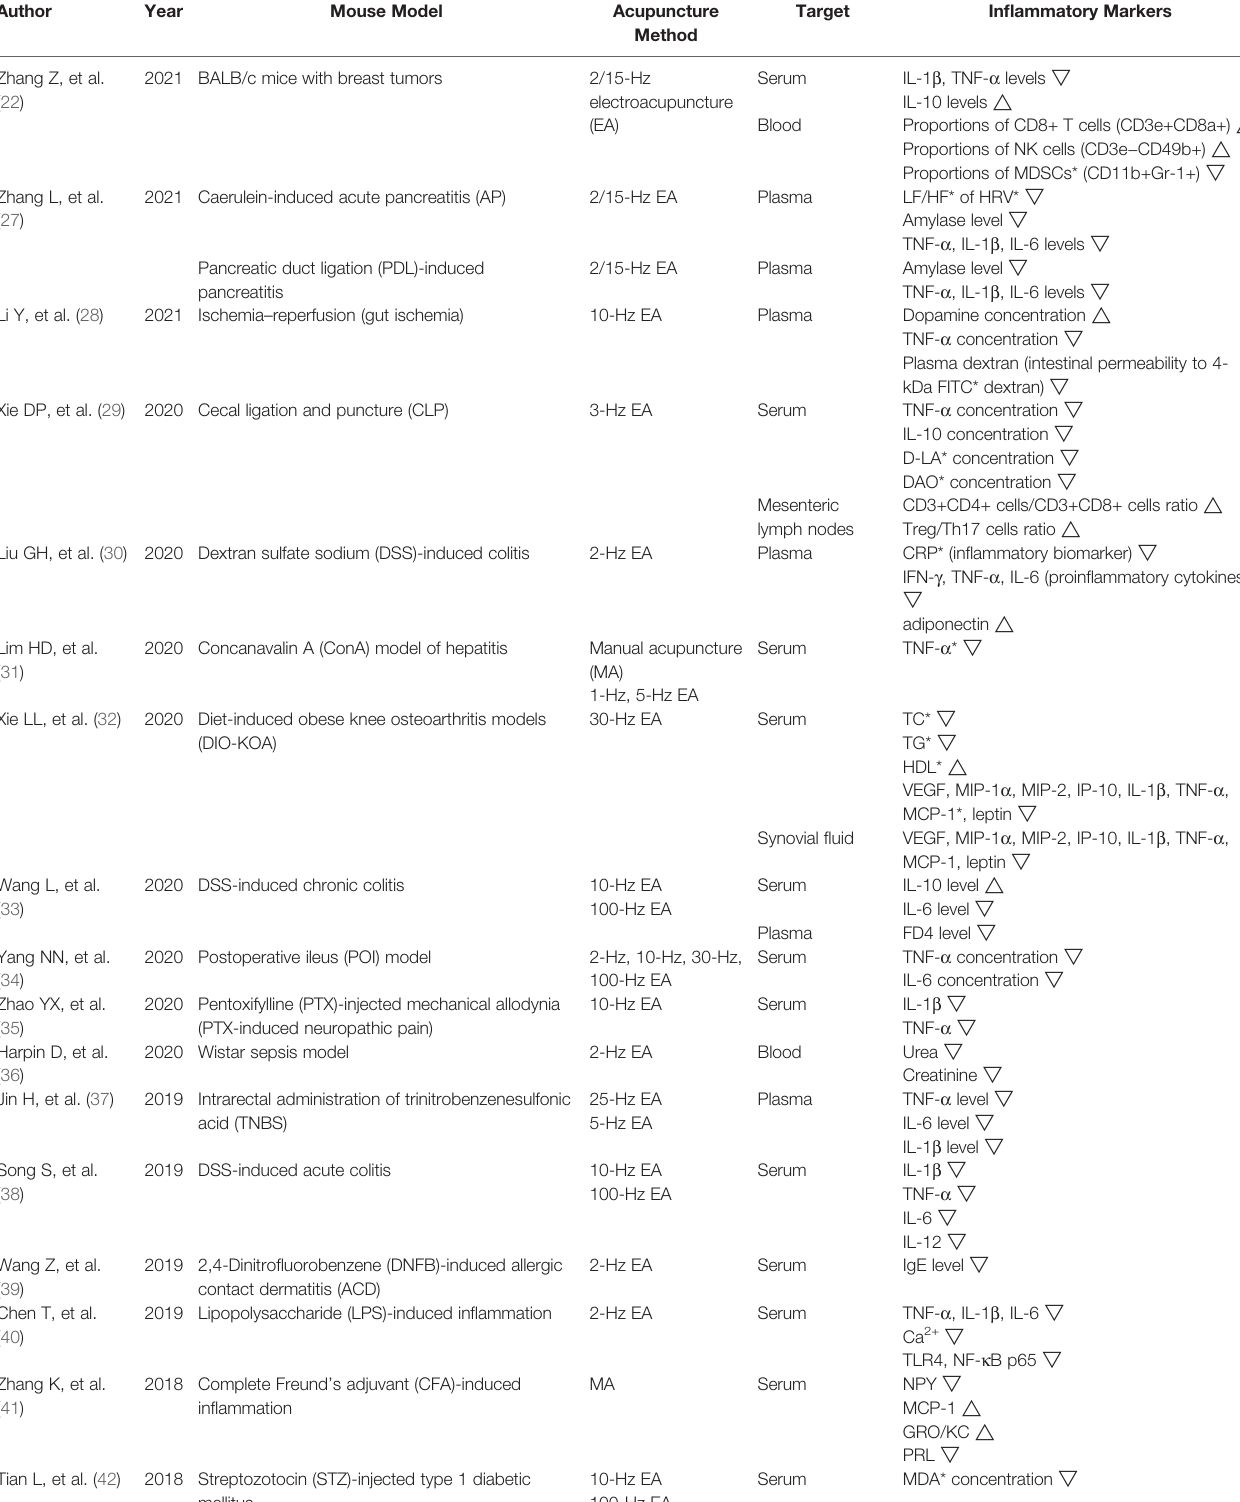
TABLE 1 | Anti-in fl ammatory effect of acupuncture on ST36 in body fl